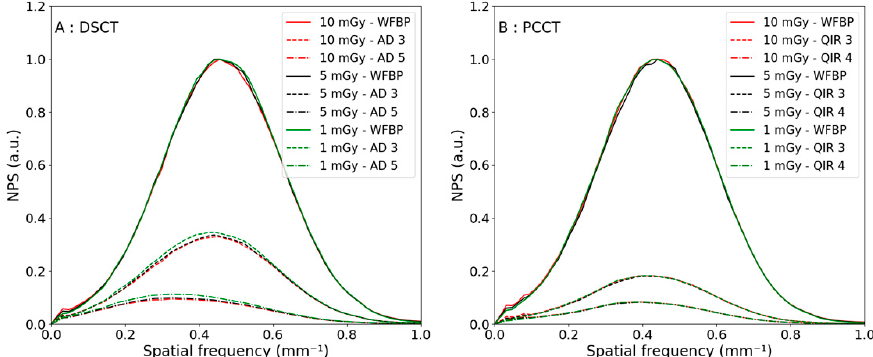
Figure 3. Noise power spectra curves in the case of polyenergetic reconstruction, with a CTDI vol of 10 mGy in red, 5 mGy in black and 1 mGy in green, when increasing the iteration level of the reconstruction algorithm for the DSCT ( A ) and the PCCT ( B ). WFBP—weighted filtered back projection and AD—ADMIRE.